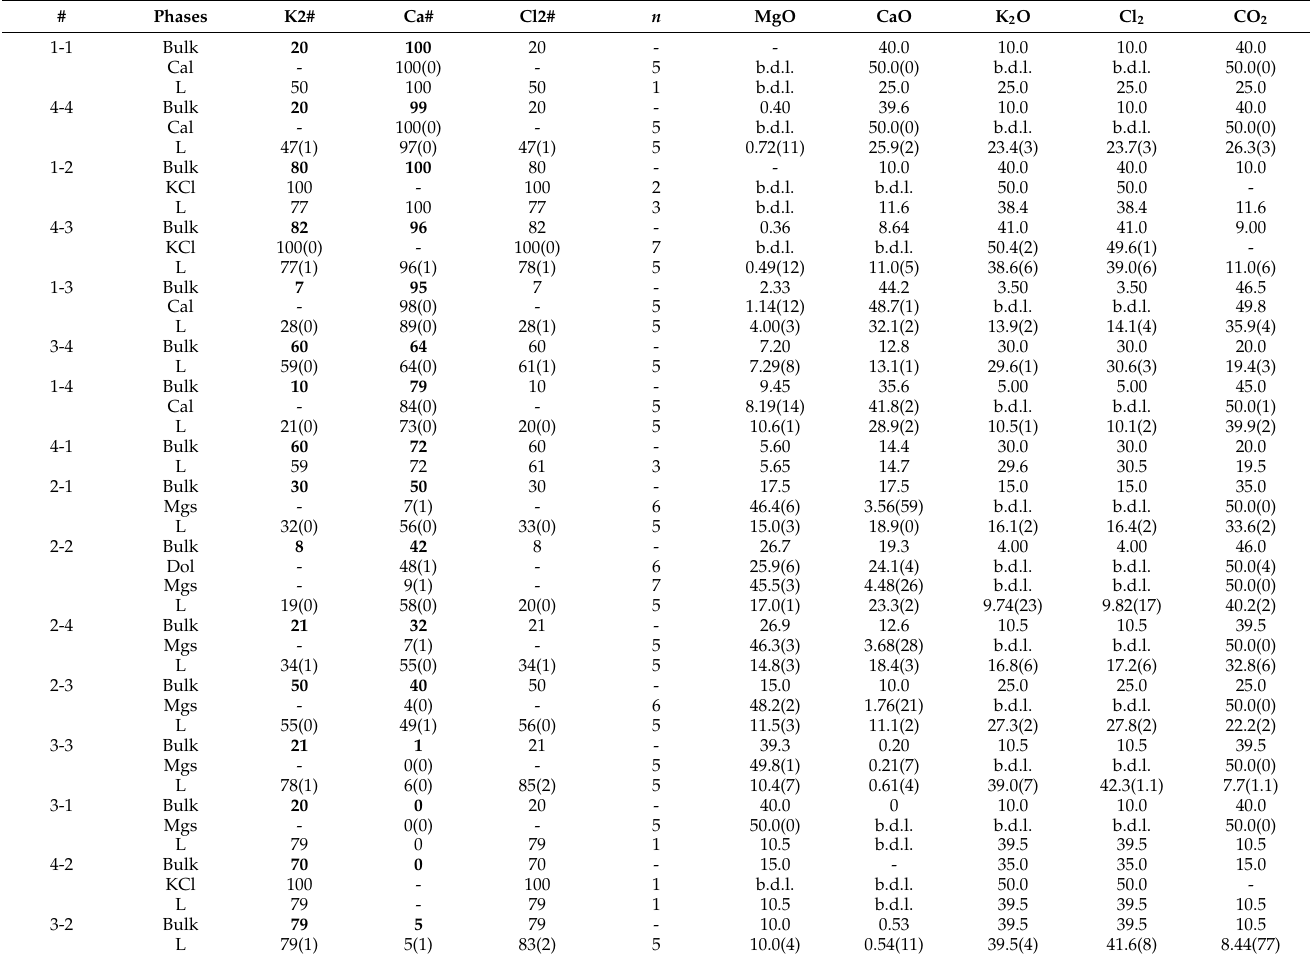
Table 3. Phase compositions (mol%) in run D308 at 1100 ◦ C and 6